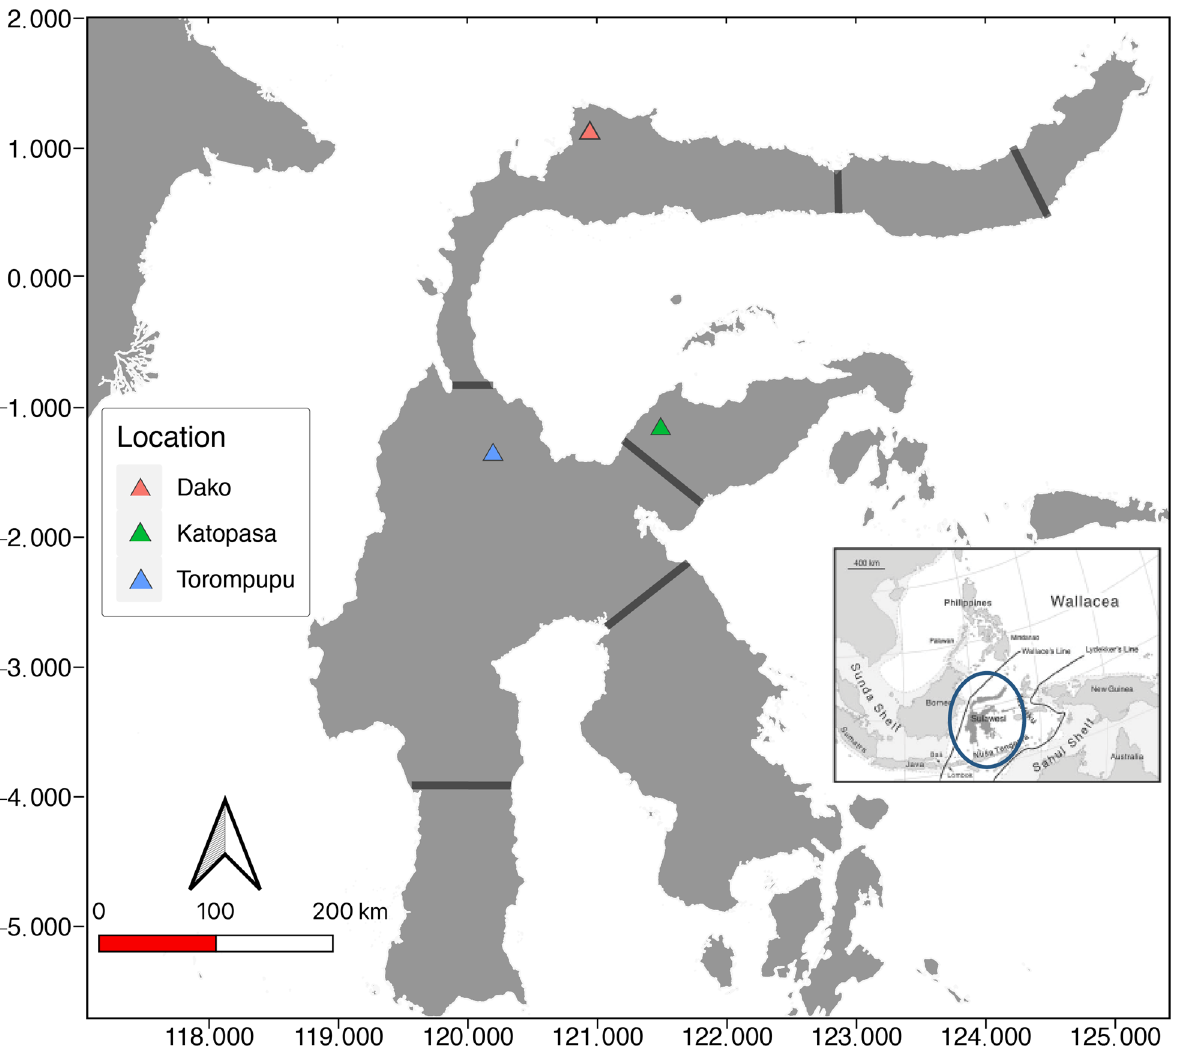
Fig. 1 Map of collecting sites on the island of Sulawesi, Indonesia. Grey bars indicate the seven Areas of Endemism (AOEs) described in [32]. The axis values are in